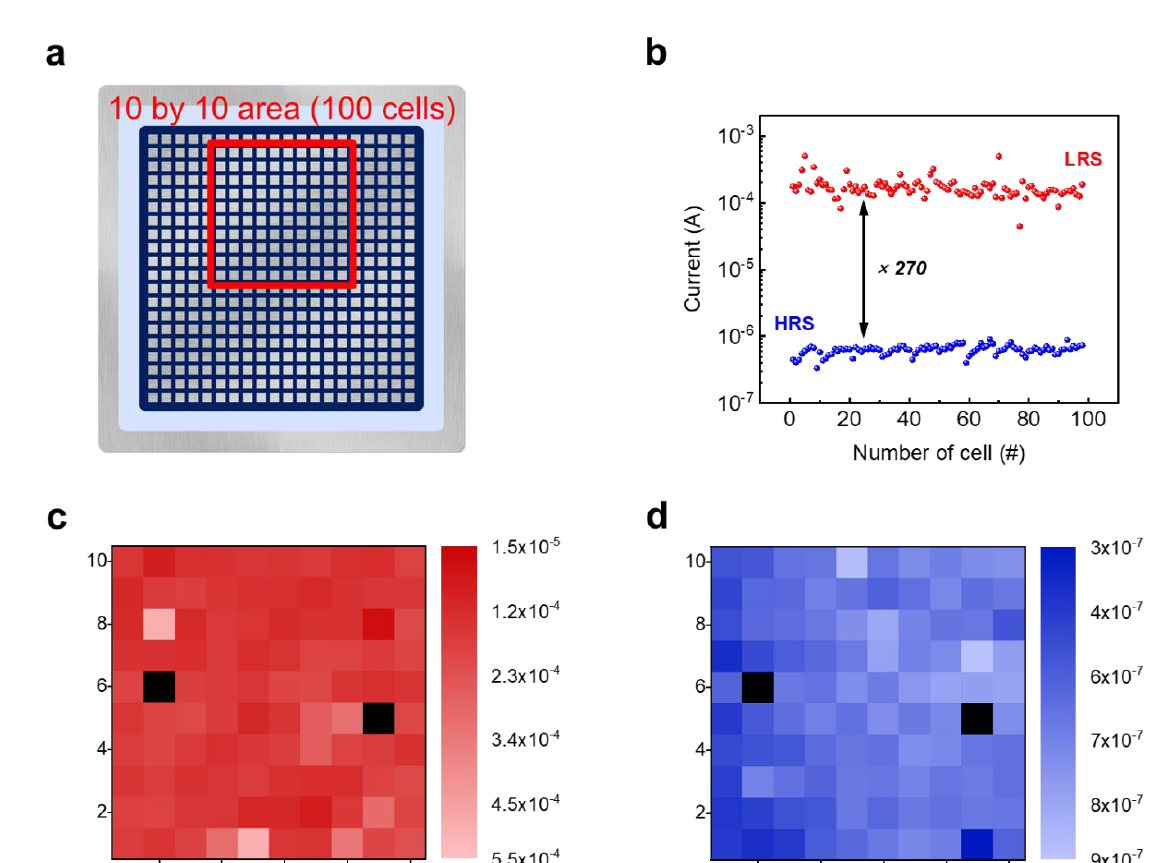
Figure 4. ( a ) Schematic diagram of the device with 400 cells which is structured 20 by 20 matrix, where the area surrounded by red solid line was selected for measurement and the area is 10 by 10 (100 cells). ( b ) Set and reset properties in selected area where the electrical shorted cells were removed. ( c , d ) Current mapping image in selected area for set and reset processes, respectively. The black colored squares indicate electrical shorted